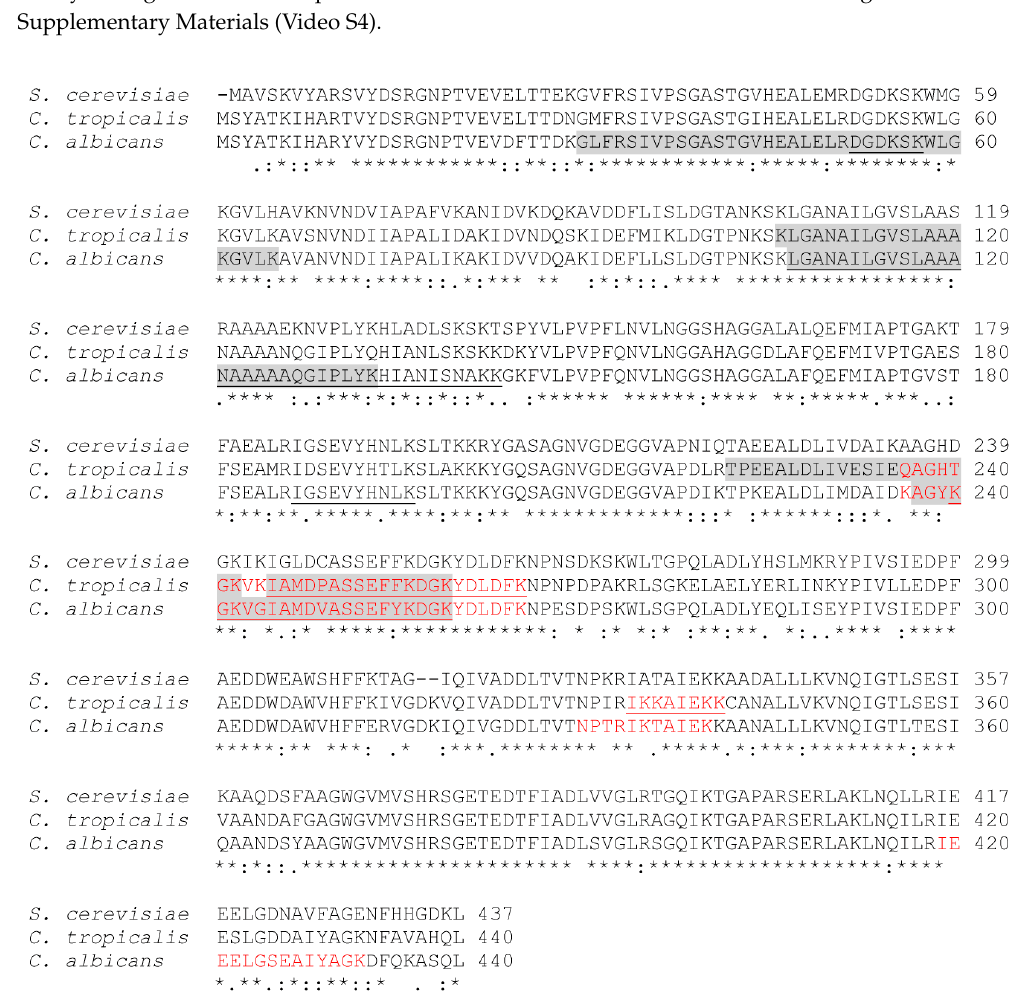
Figure 8. Comparison of the putative human protein binding sites on the C. albicans , C. tropicalis , and non-pathogenic S. cerevisiae enolases. Alignment of the enolase amino acid sequences from C. albicans (accession number P30575), C. tropicalis (accession number C5MD83) and S. cerevisiae (accession number P00929). Peptides identified during chemical crosslinking involved in the interaction with HPG are marked in a gray background, with VTR are marked with red letters, and with FN are highlighted by underlines.